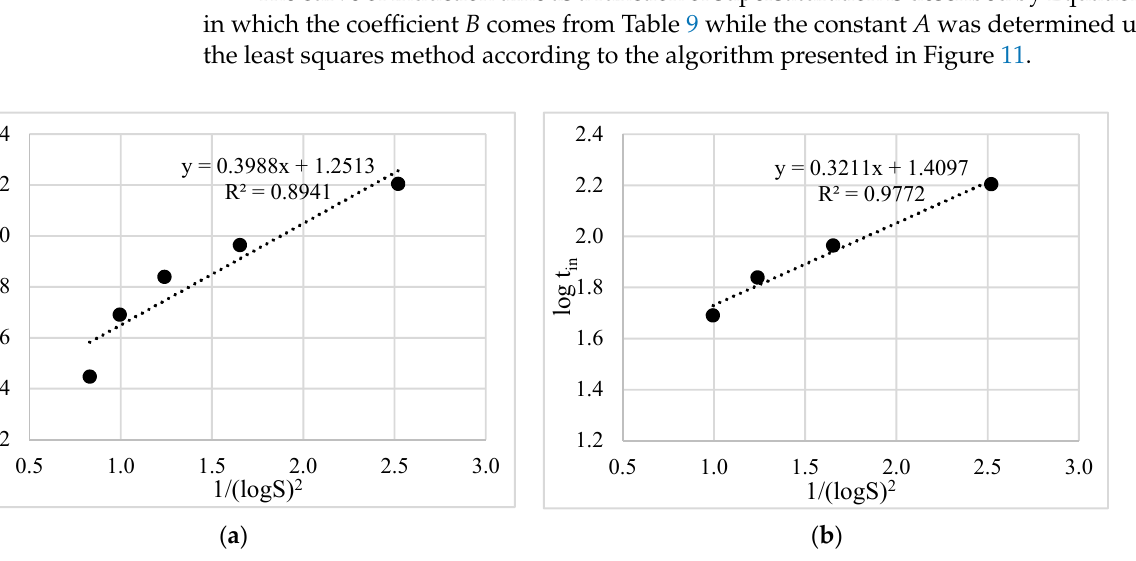
Table 9. Changes of value B as function of temperature.